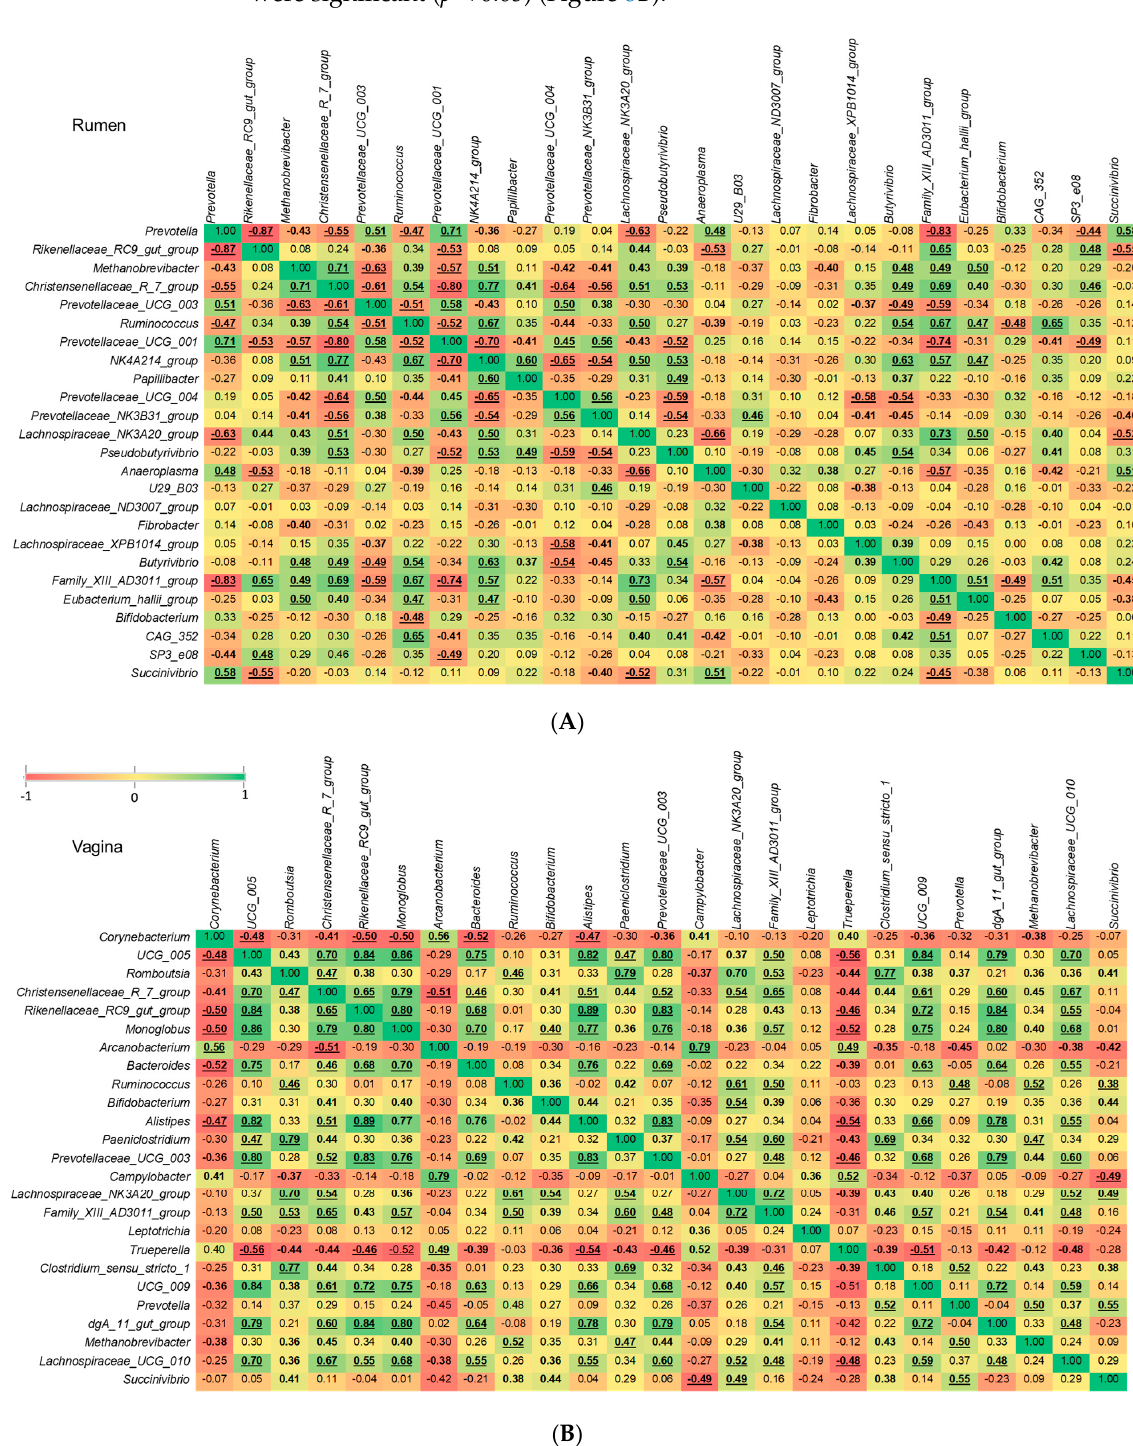
Figure 8. Correlations between the 25 most relatively abundant genera in the ruminal ( A ) and vaginal ( B ) microbiota of pregnant heifers. Spearman’s rank correlation coefficients ( r ). Bold correlation coefficients with 0.01 ≤ p < 0.05, and underlined bold correlation coefficients with p < 0.01.